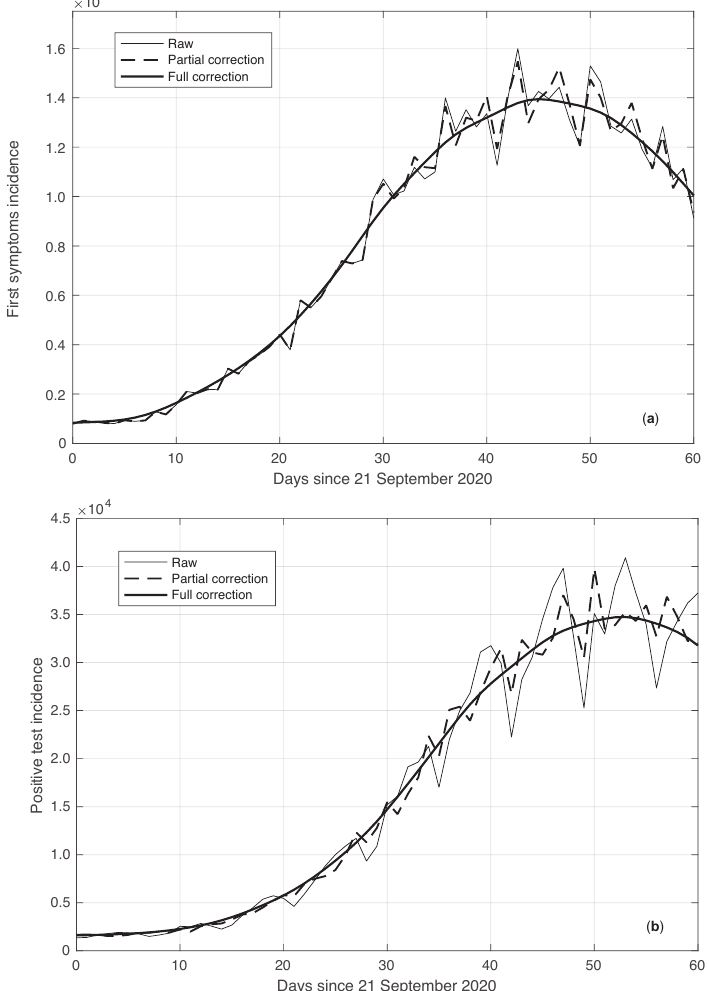
Figure 1. Real SARS-CoV-2 Italian incidence (number of new cases per day) from 21 September to 20 November 2020. In panels ( a , b ), the first symptoms and positive test data are respectively plotted. Measured data (thin continuous lines) are shown together with their corrected version from the one-week periodic component (thick dashed lines) and the non-parametric component of the model (thick continuous lines). See Section 2.2 for